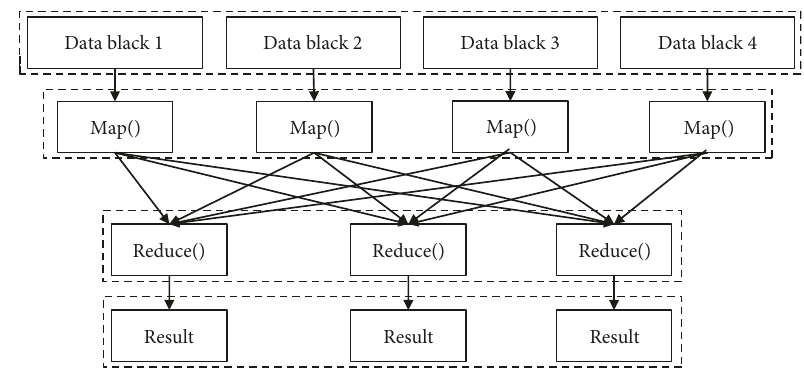
Figure 2: Working process of Table 1: Data table structure.